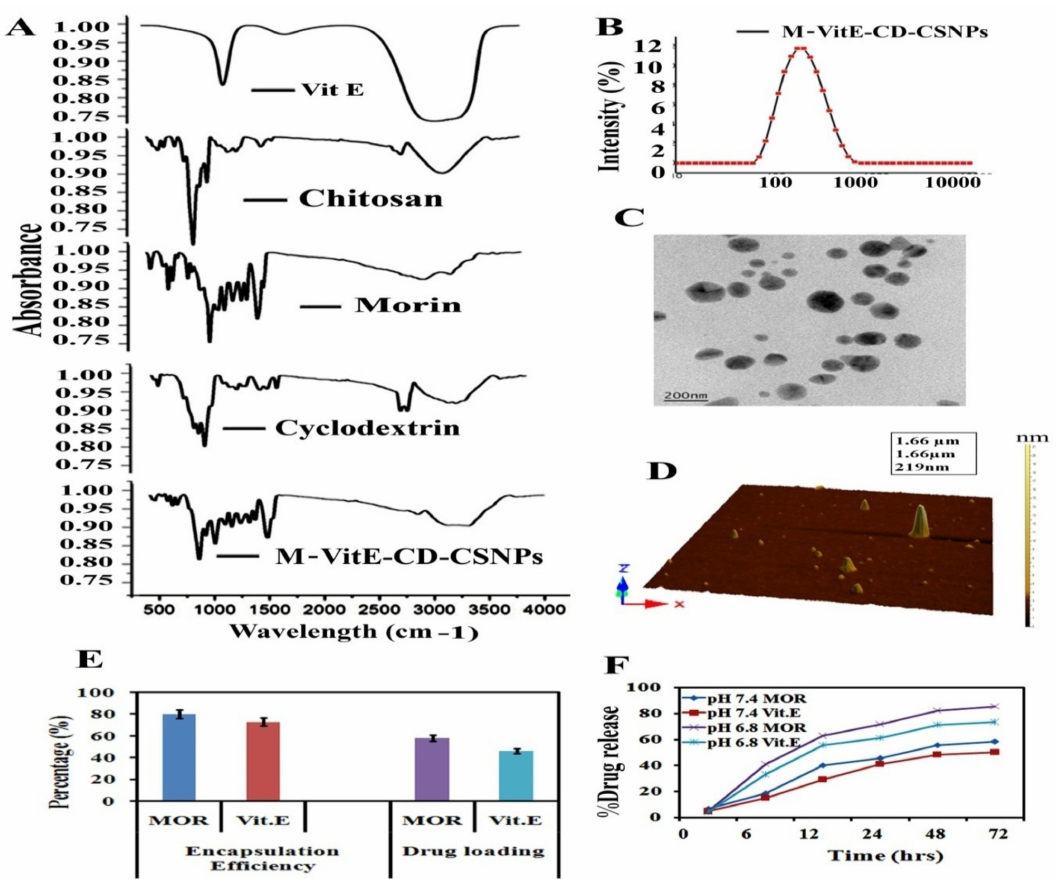
Figure 1. Characterization of Morin, vitamin E, and β -CD inclusion complex loaded chitosan nanoparticles. ( A ) Fourier transform infrared spectroscopy (FTIR) spectra of Morin, vitamin E, β -CD, chitosan, and M-Vit.E-CD-CS NPs. ( B ) Particle size distribution from differential light scattering (DLS) with M-Vit.E-CD-CS NPs. ( C ) TEM images of M-Vit.E-CD-CS NPs. ( D ) M-Vit.E-CD-CS NPs particle surface topology determination using atomic force microscopy (AFM). The acquired images were analyzed using scanning probe microscopy (SPM) tools for laboratory study. ( E ) The encapsulation efficiency percentage and the drug-loading percentage of M-Vit.E-CD-CS NPs. ( F ) The percentage of release of Morin from M-Vit.E-CD-CS NPs over a time period of 0–72 h. Result is the mean ± standard deviation (SD) from triplicate independent